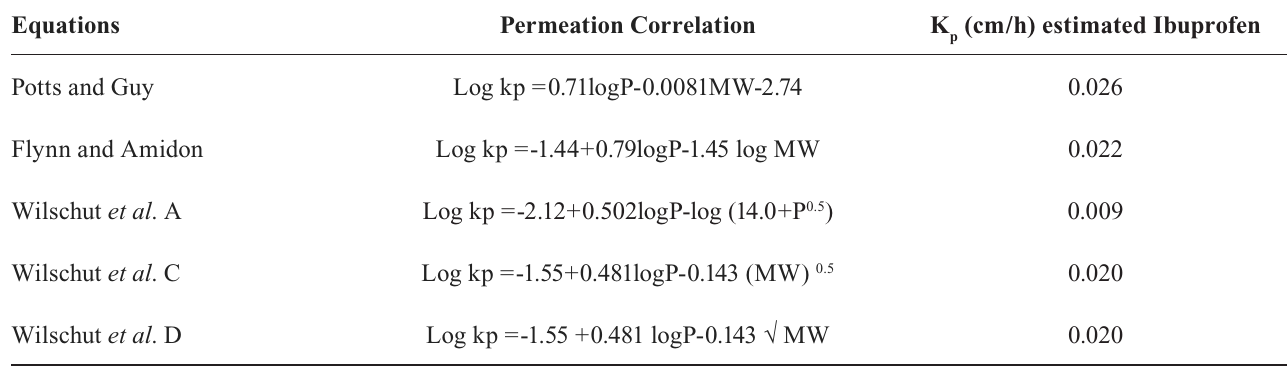
(cm/h), from different permeation correlation equations (Hadgraft and p